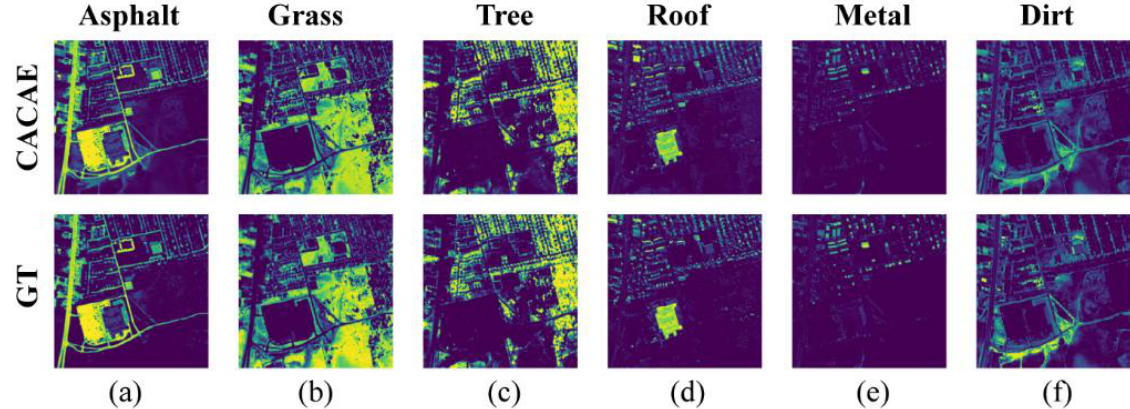
Remote Sens. 2023 , 15 , x FOR PEER REVIEW